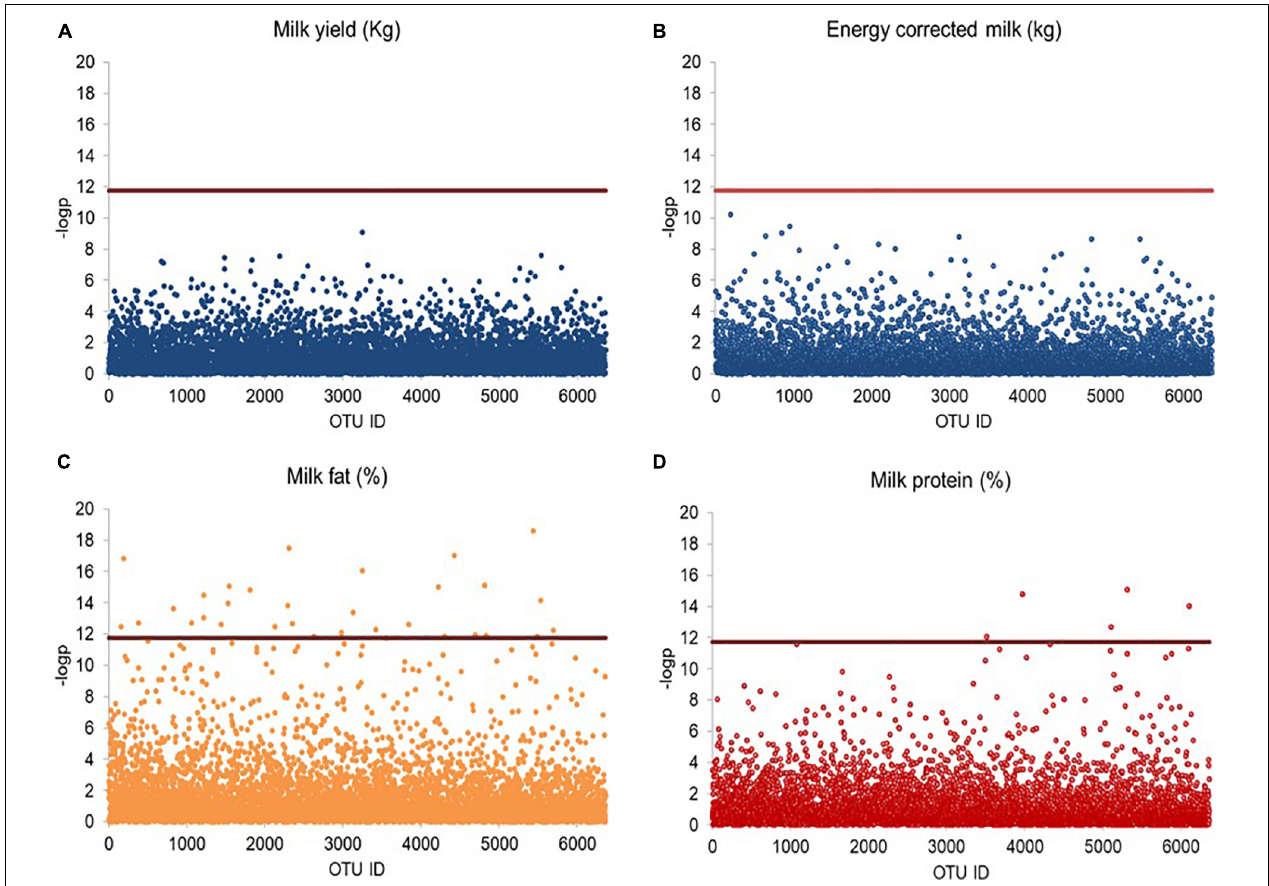
FIGURE 4 | Scatter plot illustrating OTUs significantly associated with milk traits. Rarified sequence number of individual OTUs was used as input for the linear mixed model-based significance detection. Negative log base 10 transformed P value of individual OTUs ( y -axis) was plotted against their corresponding OTU identities ( x -axis). Bonferroni corrected false discovery threshold (0.05/6,363) is used as baseline for significance control as indicated by red line and individual OTUs are represented by open blue circle. The OTUs above the red baseline are considered as OTUs with significant effect on milk traits. (A) Milk production, (B) energy corrected milk, (C) milk fat percentage, and (D) milk protein percentage are shown in Manhattan